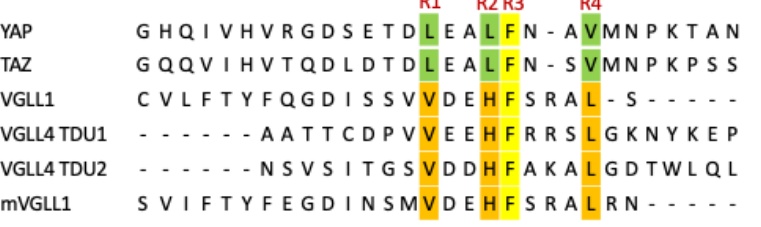
Figure 5. Sequence alignment of the interface 2 α -helix region of the coregulators. Four hydrophobic residues (R1, R2, R3, and R4) are labeled. The conserved residues in YAP/TAZ are highlighted in green; the conserved residues in VGLL family in orange; the highly conserved residues in all co-regulator proteins are highlighted in yellow.